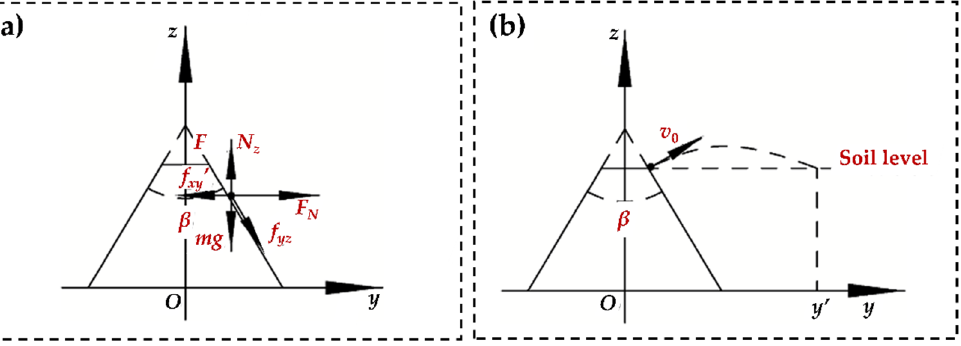
Figure 16. Sliding–cutting curve and soil particle motion analysis. ( a ) Sliding–cutting curve. ( b ) Dis- tance of soil particles moving along the sliding–cutting edge. ( b ) Distance of soil particles moving along the sliding–cutting edge.